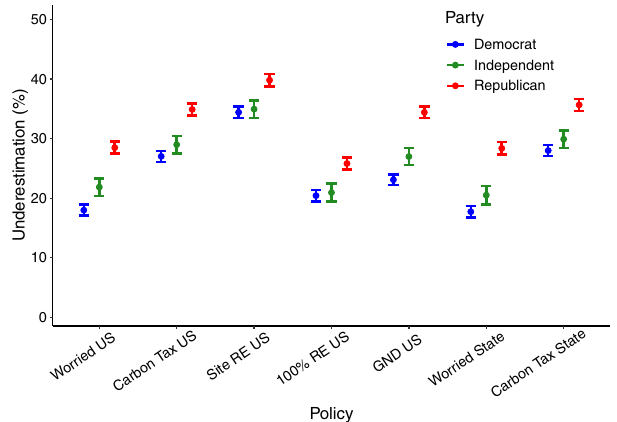
Fig.3|Partisanlevelsofpluralisticignoranceforclimateworryandsupportfor climate policy. Pluralistic ignorance is calculated as the difference between real and perceived norm levels, so greater values indicate real levels are higher than perceived norms (i.e. greater underestimation). All perceptions pertain to either theentirenationorone ’ sstate(notone ’ sfellowpartisans).Itemsontheleftlabeled with “ US ” indicateestimatesofsupportforpoliciesatthenationallevel,whilethose on the right labeled with “ State ” indicate estimates of support for those in parti- cipants ’ own state. Error bars represent 95% con fi dence intervals of the mean dif- ferences illustrated. RE refers to renewable energy, and GND refers to the Green New Deal. N =6119 survey participants, including 2777 Democrats, 1022 Indepen- dents, and 2320